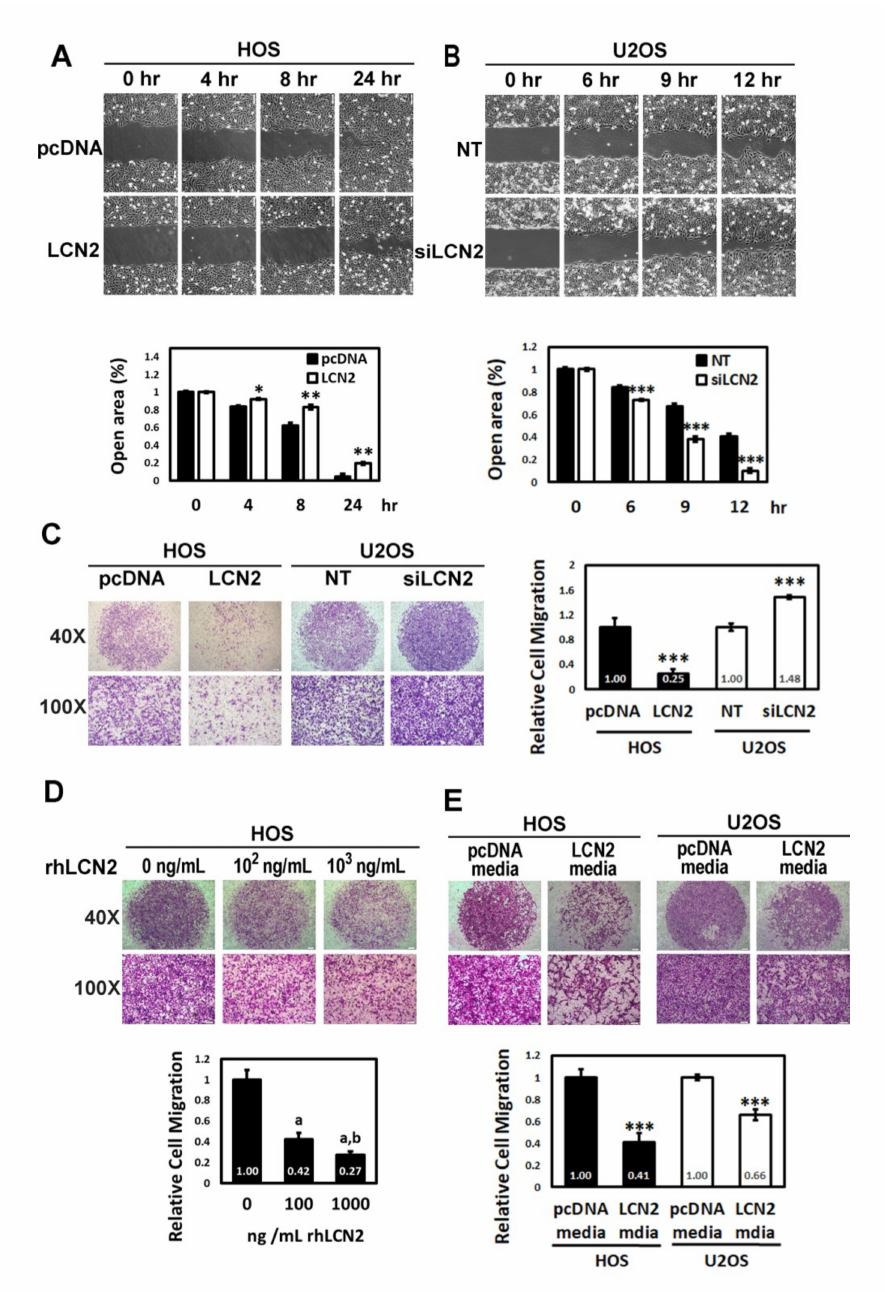
Figure 2. Effects of LCN2 on cell motility and migration of human osteosarcoma cells. ( A , B ) Effects of HOS cells after transfection with vectors containing constitutively active LCN2 cDNA and U2OS cells after siRNA directly against the LCN2 expression in wound healing assay were measured. * p < 0.05, ** p < 0.01, and *** p < 0.001 compared with the vehicle group. ( C ) Using a cell migration assay, migratory HOS cells after transfection with vectors containing a constitutively active LCN2 cDNA and U2OS cells after siRNA directly against the LCN2 expression were measured and subsequently subjected to quantitative analysis. *** p < 0.001 compared with the vehicle group. ( D , E ) Cell migration assays for HOS cells after treatment with various concentrations (0, 100, and 1000 ng/mL) of recombinant human LCN2 and both HOS and U2OS cells after treatment with culture media of LCN2 overexpression HOS cells were measured and subsequently subjected to quantitative analysis. F: 132.128, p < 0.001. a Significantly different, p < 0.05, when compared with control. b Significantly different, p < 0.05, when compared with 100 ng/mL. *** p < 0.001 compared with the vehicle